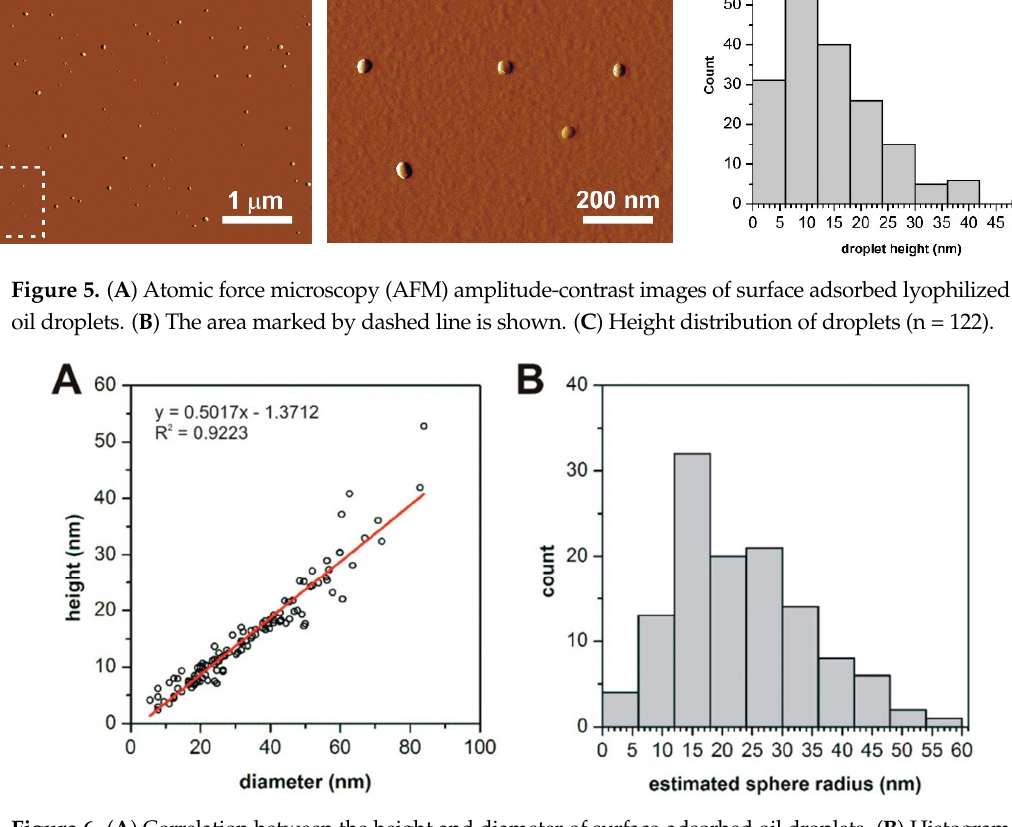
Figure 6. ( A ) Correlation between the height and diameter of surface-adsorbed oil droplets. ( B ) Histogram of estimated radius of oil droplets in the fluid phase. Estimation based on volume of surface-absorbed droplets (n = 122).